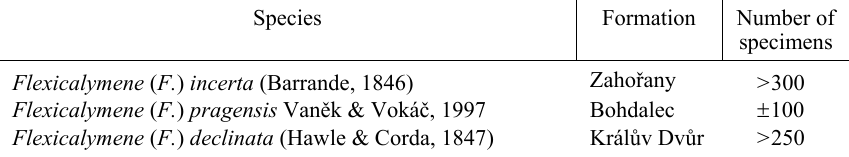
Table 2. Species of the genus Flexicalymene Shirley, 1936 in the Ordovician of the Prague Basin Species Formation Number of specimens